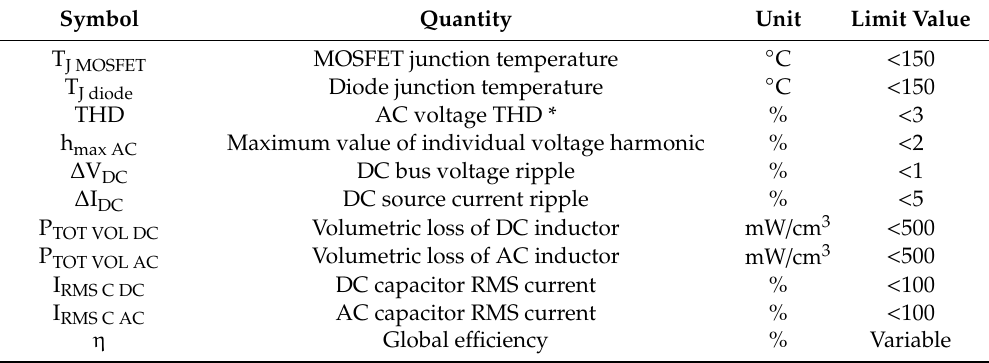
Table 2. Main constraints of the studied converter.